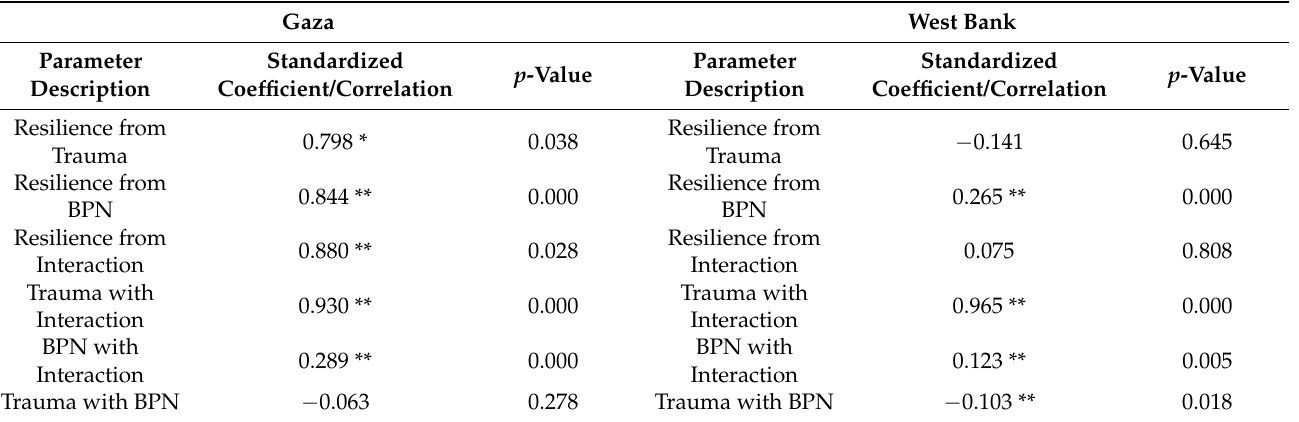
Table 3. Standardized regression weights and correlation coefficients for the interaction model (second